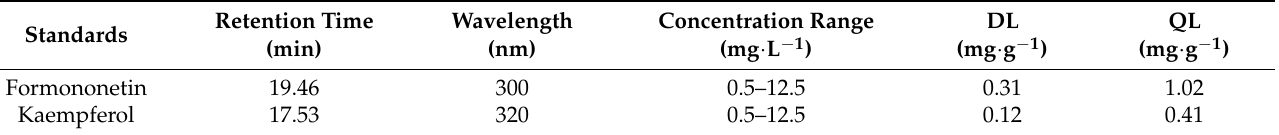
Table 2. Identification and quantification conditions by HPLC-DAD of the compounds formononetin and kaempferol in red propolis extracts obtained by different